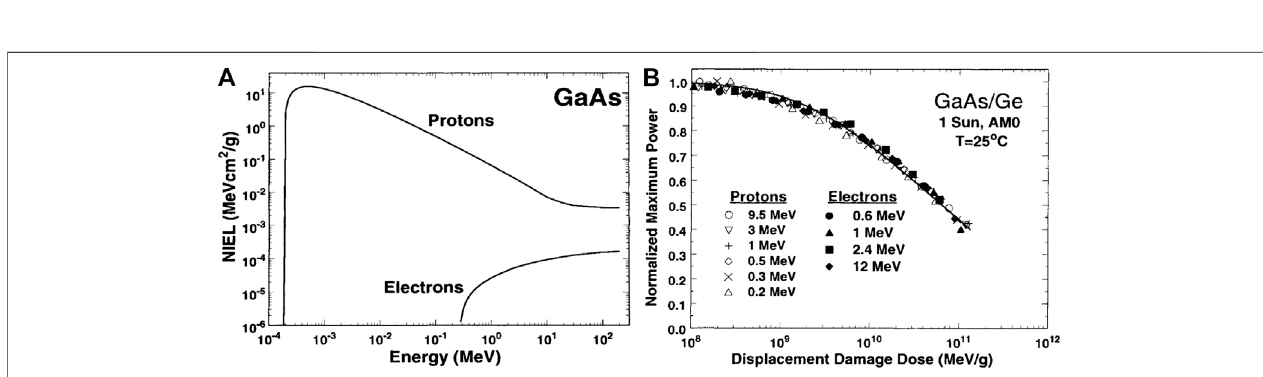
FIGURE 8 | Relative damage coef fi cient for omnidirectional (A) proton and (B) electron irradiation of shielded GaAs/Ge solar cells [89].